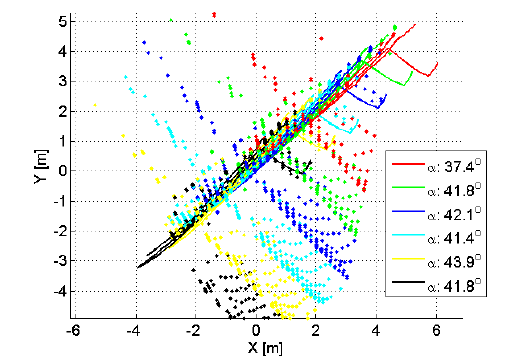
Figure 6. Fitted consecutive scans and